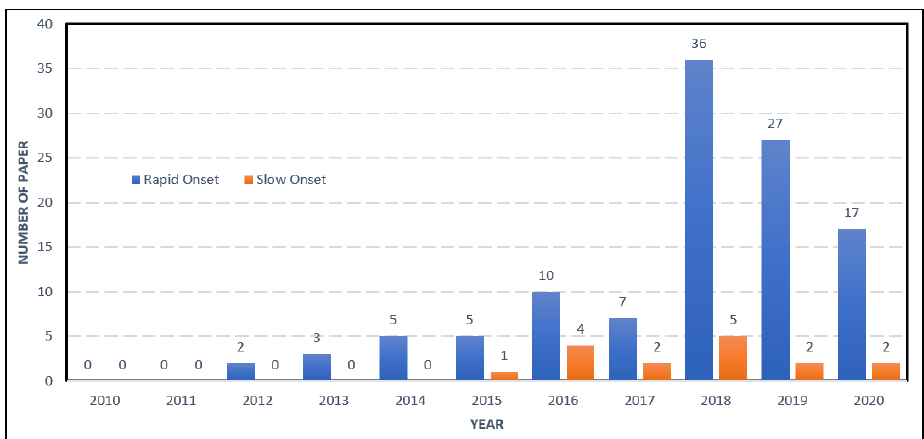
Figure 36. Disaster Phases Addressed by Literature According to Year of Publication.